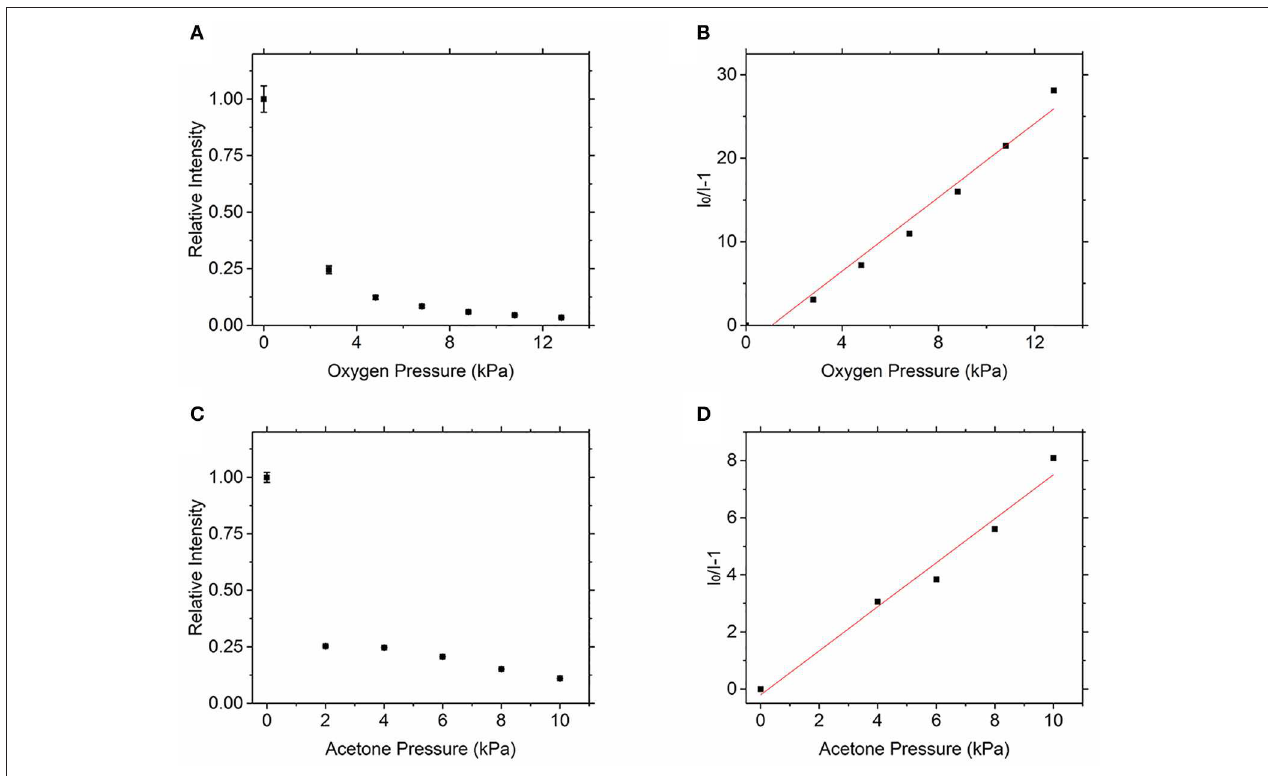
FIGURE 5 | Relative fluorescence intensity of toluene vs. oxygen (A) and acetone (C) partial pressure and dependence of toluene LIF on quenching by oxygen (B) and acetone (D) .